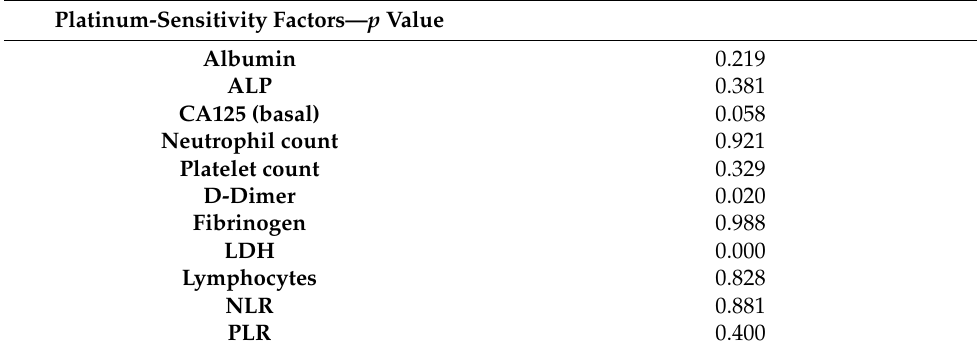
Table 5. Platinum-sensitivity multivariate analysis. Table shows the results of a multivariate analysis obtained by selecting each independent prognostic factor calculated on the basis of a univariate analysis. Platinum-Sensitivity Factors— p Value Albumin 0.219 ALP CA125 (basal) Neutrophil count Platelet